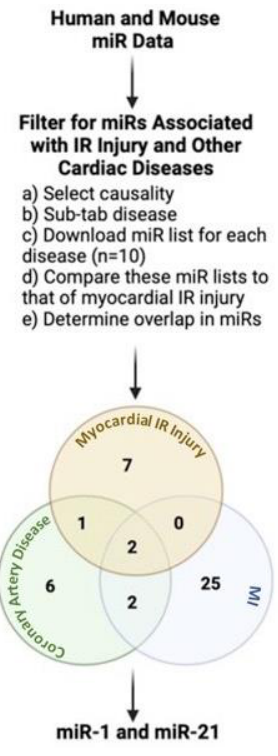
Figure 1. HMDD pipeline to filter for miRs dysregulated in myocardial IR injury and other cardiac diseases. miR-1 and miR-21 are dysregulated in myocardial IR injury, CAD, and MI. The findings from the HMDD analysis for miR-1 have been modified with a literature search to include CAD and myocardial IR injury. IR: ischemia-reperfusion injury; MI: myocardial infarct. Created with BioRender.com.